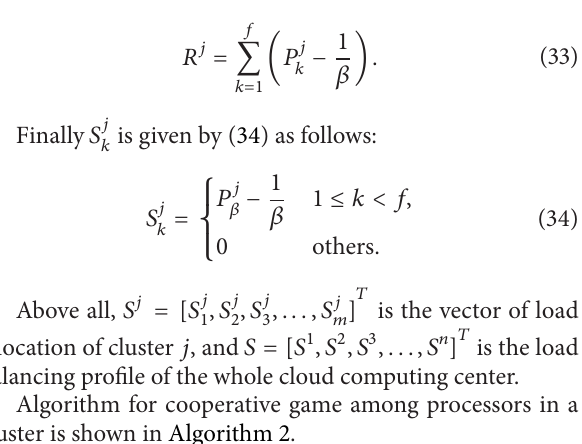
cluster is shown in Algorithm